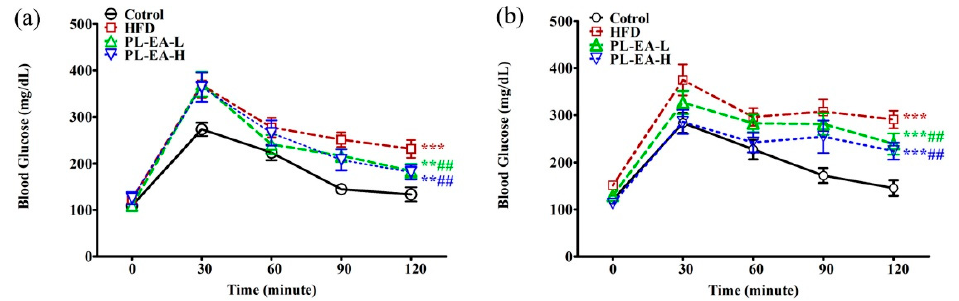
Figure 6. Effects of ethyl acetate fraction from P. linteus mycelia on the OGTT at week 9 ( a ) and at week 14 ( b ). HFD: high-fat/high-fructose diet (HFD). PL-EA-L: HDF + low dose PL-EA (35 mg/kg). PL-EA-H: HDF + high dose PL-EA (70 mg/kg). Data are expressed as mean ± SE ( n = 9). ## p < 0.01; vs. the HFD group; ** p < 0.01; *** p < 0.001 vs. the control.